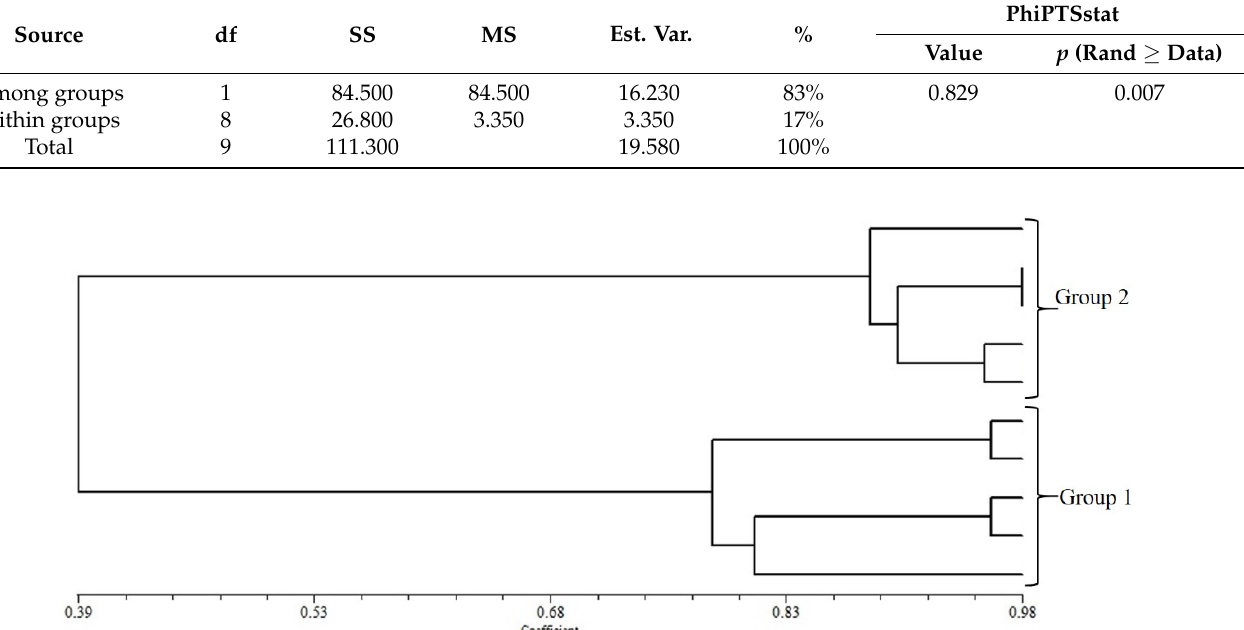
Table 5. AMOVA analysis of two tree groups’ genetic diversity.